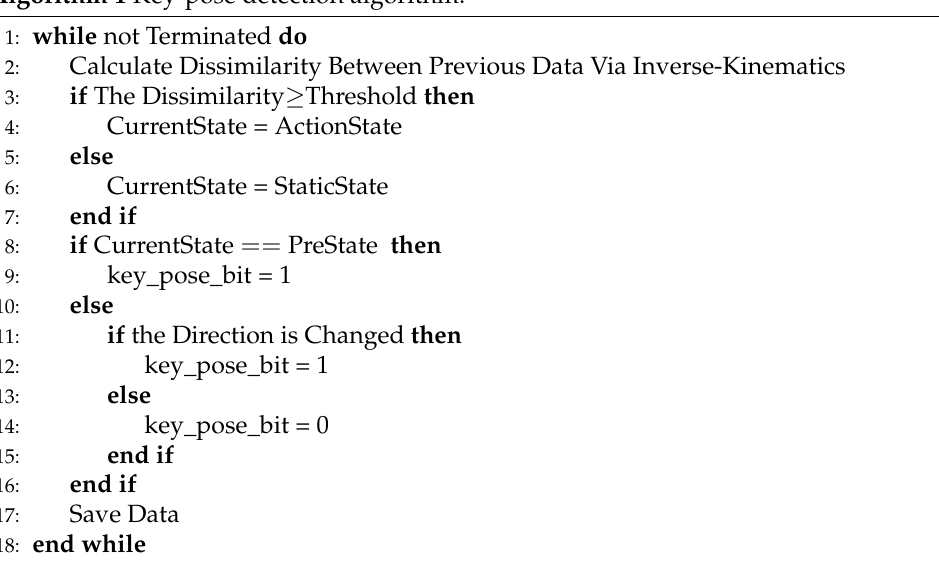
Algorithm 1 Key-pose detection